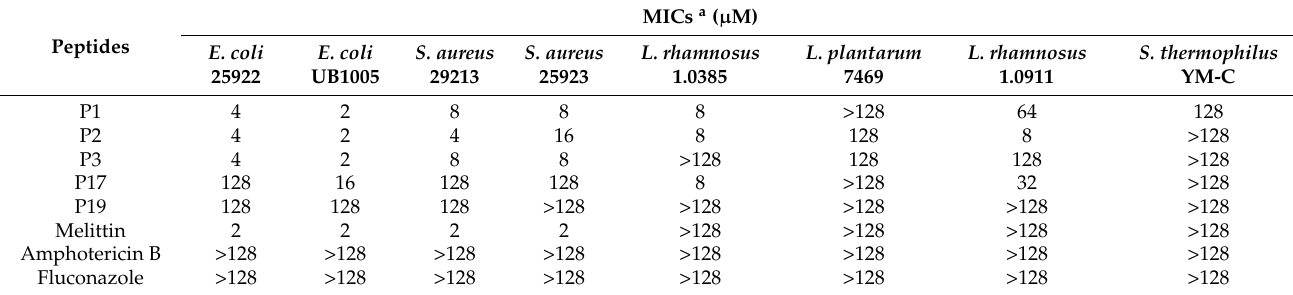
Table 2. The MICs of the peptides against bacteria.